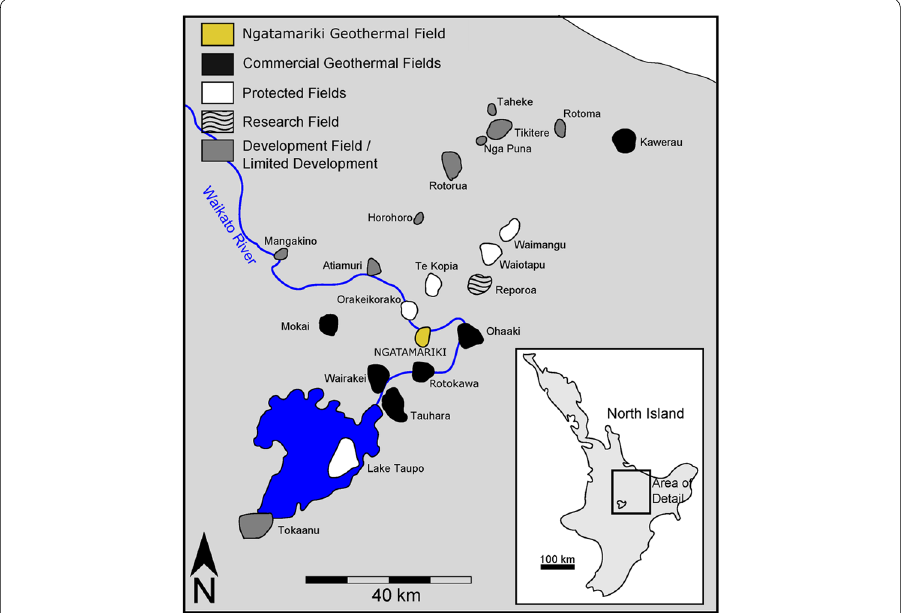
Fig. 1 Known geothermal fields within the TVZ as defined by the resistivity boundaries given by Bibby et al. (1995) (Modified from Boseley et al.